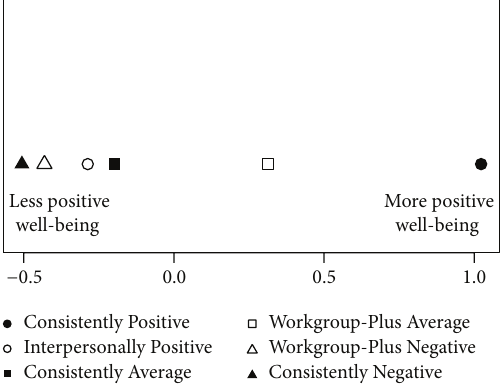
Table 3: Number of individuals (Sample 1) or groups (Sample 2) per